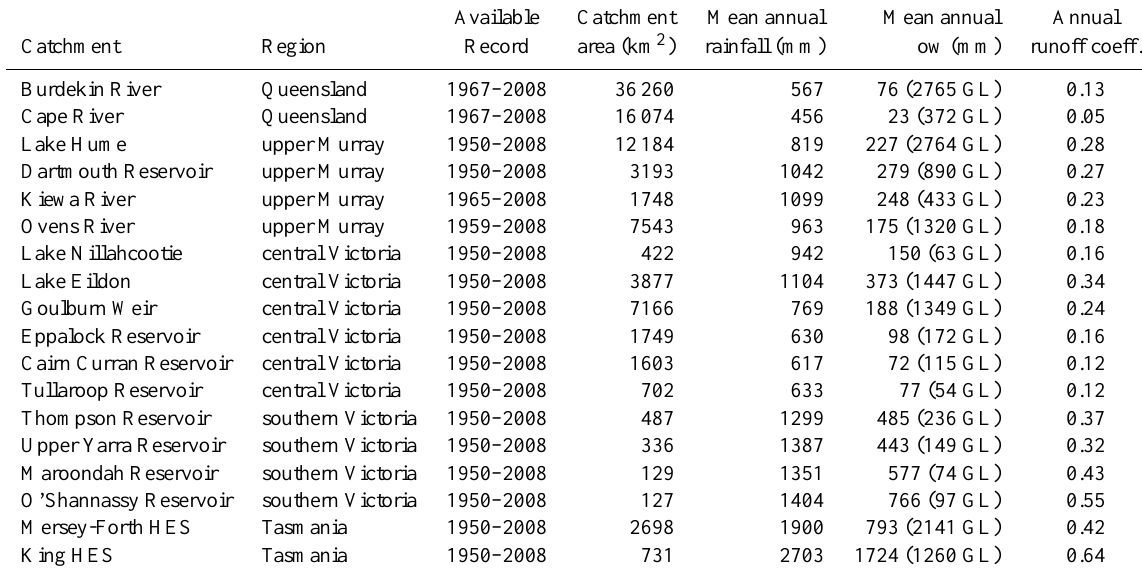
Table 1. Brief attributes of the 18 catchments used for the